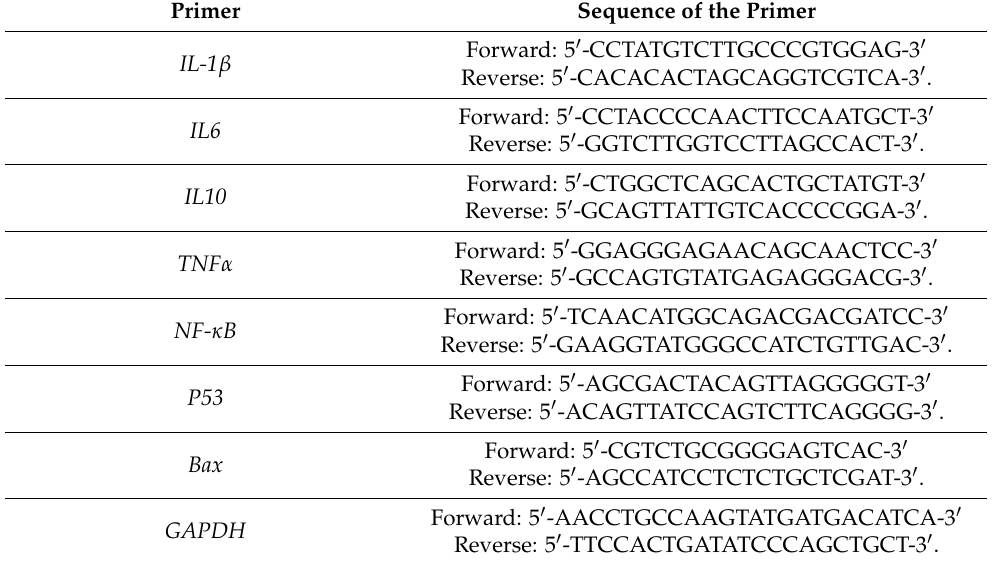
Table 1. Sequences of the